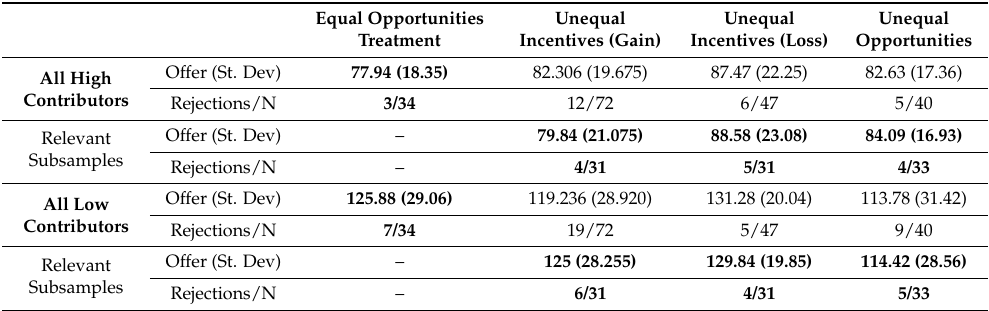
Table 7. Distribution offers and negotiation failure in case of unequal